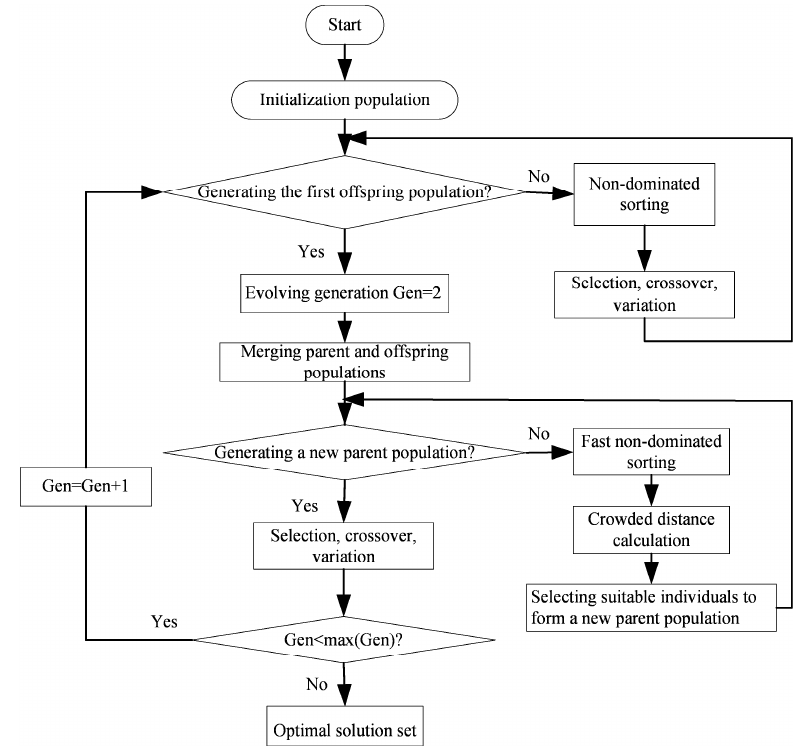
Figure 9. Flow chart of NSGA-II [62].